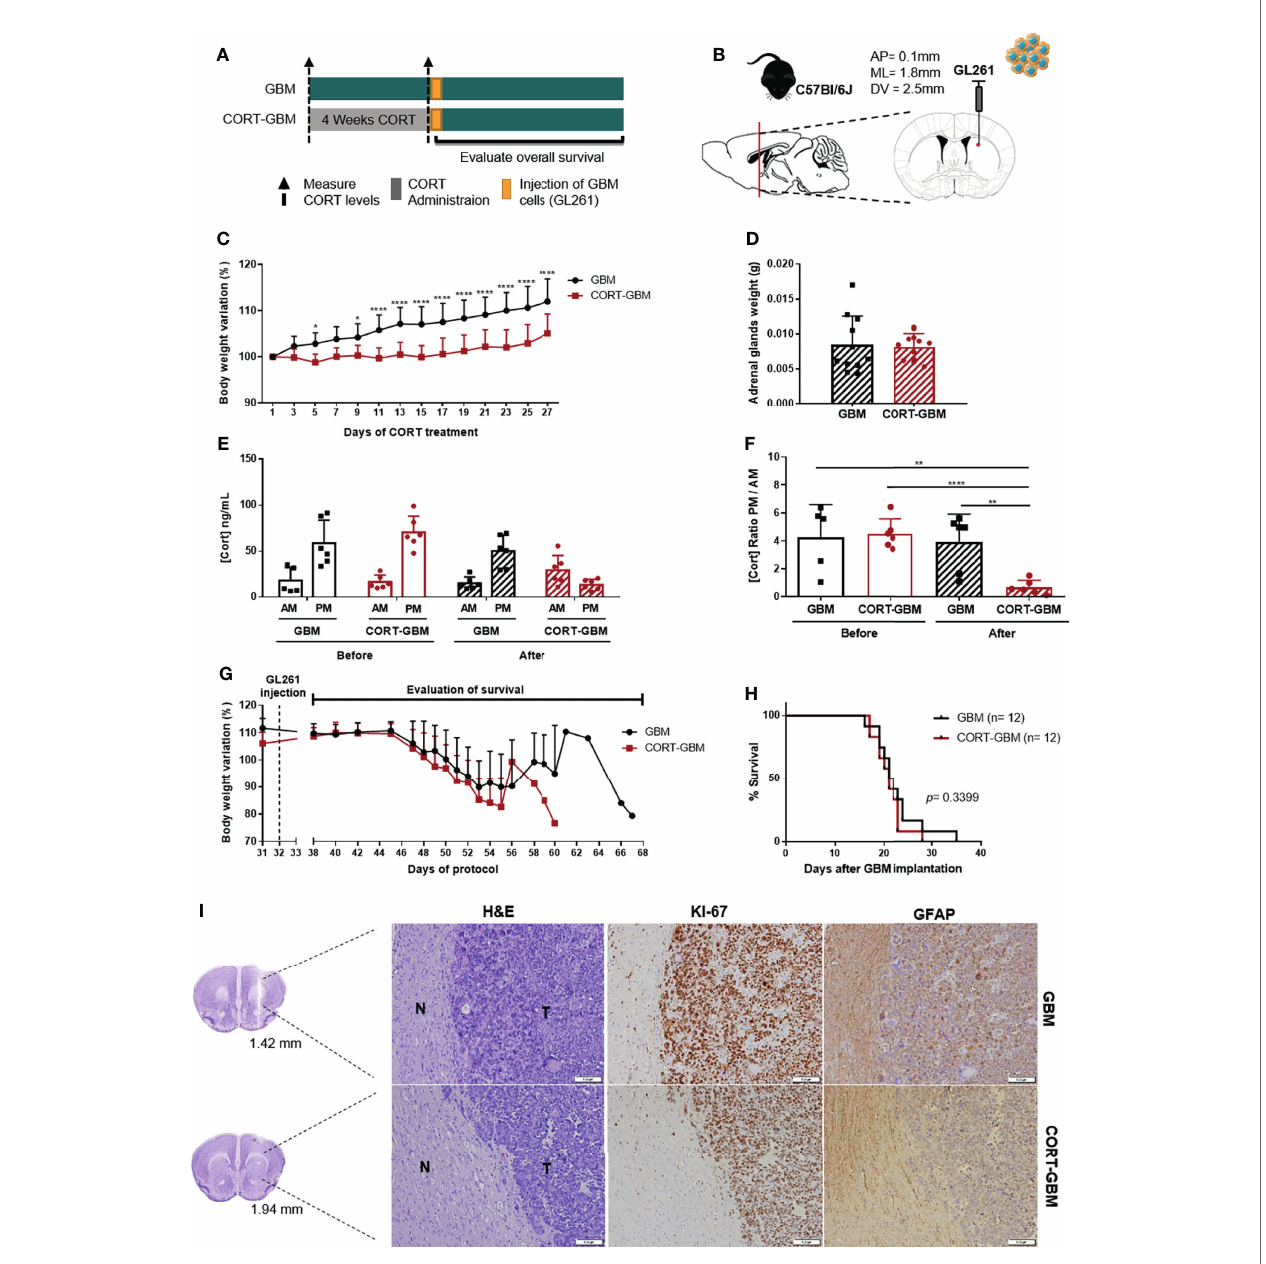
FIGURE 1 | Corticosterone administration does not affect the survival of C57BL/6J mice orthotopically implanted with a mouse GBM cell line. (A) Experimental Design. C57BL/6J mice were subcutaneously injected daily with CORT (CORT-GBM group) or with the vehicle (GBM group) for 4 weeks before the orthotopic injection of a mouse GBM cell line, GL261, followed by the evaluation of mice body weight and overall survival. (B) Sagittal and coronal representation of the stereotactic injection site of GL261 cells into the mouse brain with the following coordinates from bregma (AP = 0.1 mm; ML = 1.8 mm; DV = 2.5 mm). (C) Body weight variation percentage from initial weight of GBM (black; n = 12) and CORT-GBM (red; n = 12) groups during administration of CORT, with multiple comparisons in each day. (D) Adrenal glands weight upon sacri fi ce of animals (n = 12 per group). (E) Serum CORT levels of GBM and CORT-GBM groups from morning (AM) and evening (PM) blood collections before and after the CORT administration (n = 6 per group). (F) Ratio of evening (PM) per morning (AM) CORT circulating levels of GBM and CORT-GBM groups before and after CORT administration (n = 6 per group). (G) Body weight variation percentage from initial weight of GBM (black; n = 12) and CORT-GBM (red; n = 12) groups after orthotopic GL261 injection. (H) Kaplan – Meier survival curves of GBM (black, n = 12) and CORT- GBM (red, n = 12) groups. (I) Representative coronal sections of the mouse brain area (GBM at 1.42 mm and CORT-GBM at 1.94 mm from bregma). Hematoxylin- eosin staining of mice brains presenting a tumor area (T) and surrounding non-tumor brain tissue (N). Immunohistochemical staining for Ki67 and GFAP of mice brains orthotopically-injected with GL261 cells of GBM group and CORT-GBM group. Magni fi cation of 100x (Scale = 100 m m). *p < 0.05; **p < 0.01; ****p <